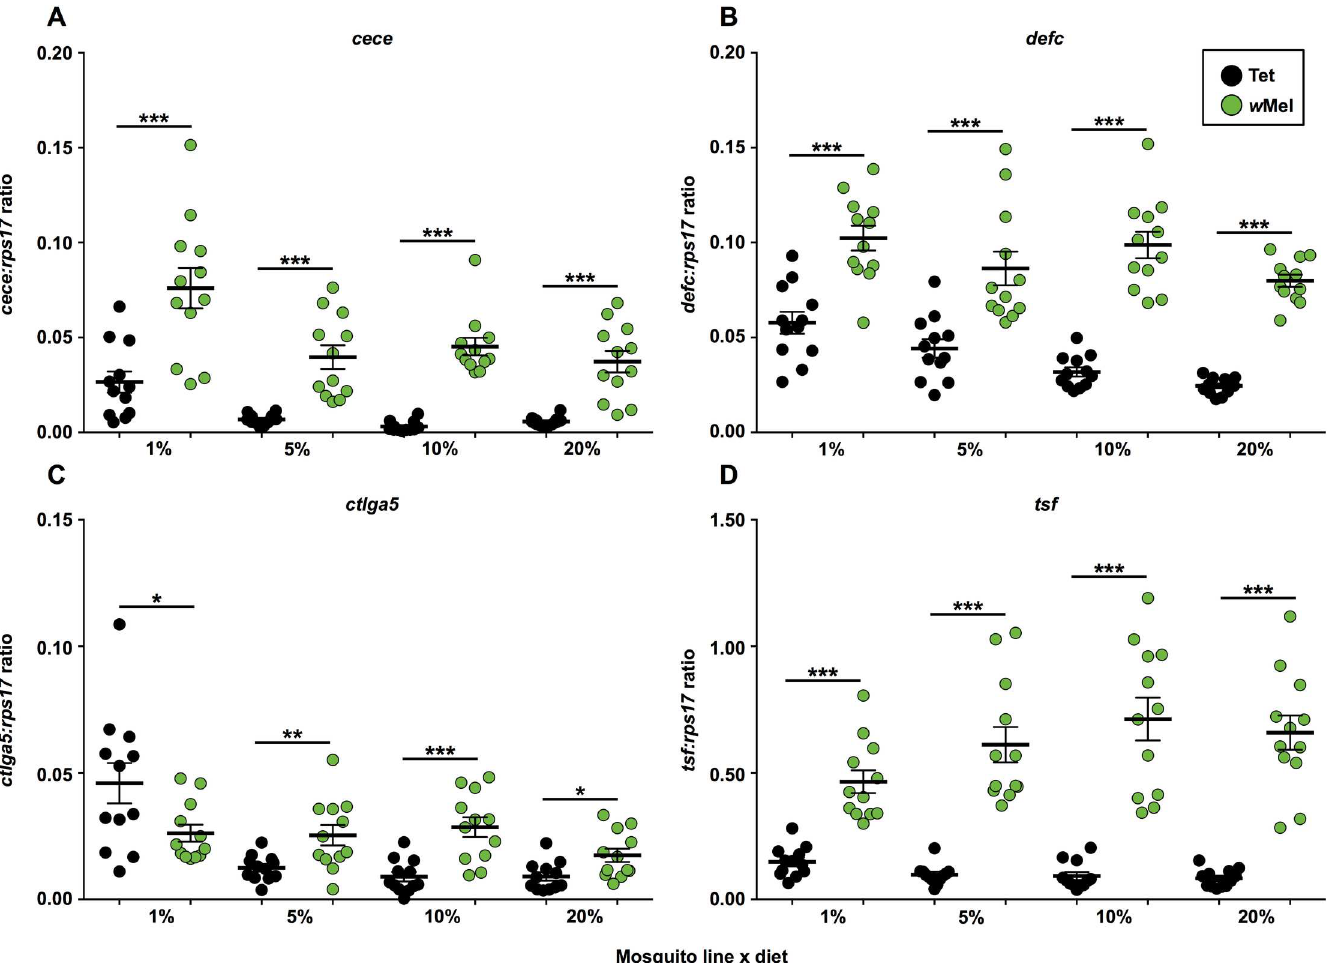
Fig 4. Immune activation in w Mel-infected Ae . aegypti fed on different carbohydrate regimes. Levels of 4 key immune genes, CecropinE ( cece ) (A) , DefensinC ( defc ) (B) , C-type lectin, galactosebinding5 ( ctlga5 ) (C) , and Transferrin ( tsf ) (D) , were quantified through RT-qPCR for w Mel (+ Wolb ) and Tet (- Wolb ) mosquitoes, after 7 days feedingon their respectivecarbohydrate diets. Expression levels were normalized against host rps17 expressionlevels. Each circle represents one pair of either Tet (black circles) or w Mel (green circles) mosquitoes,with 12 samples examinedfor each treatment. Solid black lines represent mean expression( ± s.e.m.). P values: Student’s t tests, * < 0.05, ** < 0.01 *** <